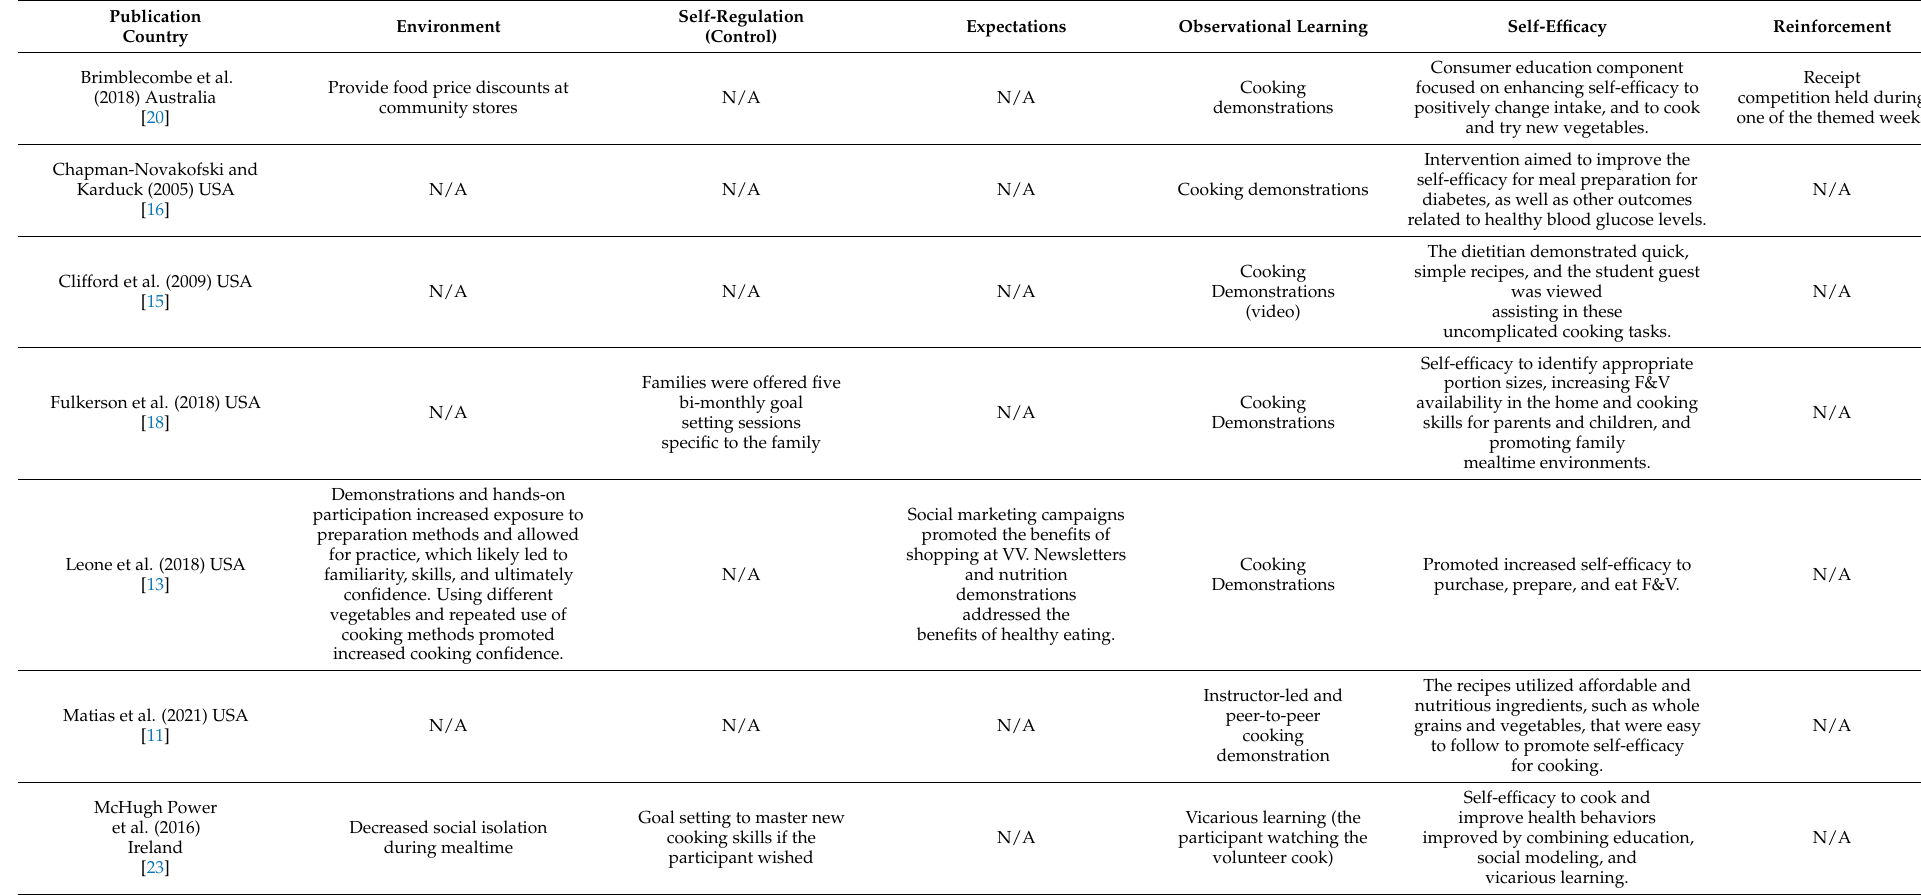
Table 3. Social Cognitive Theory